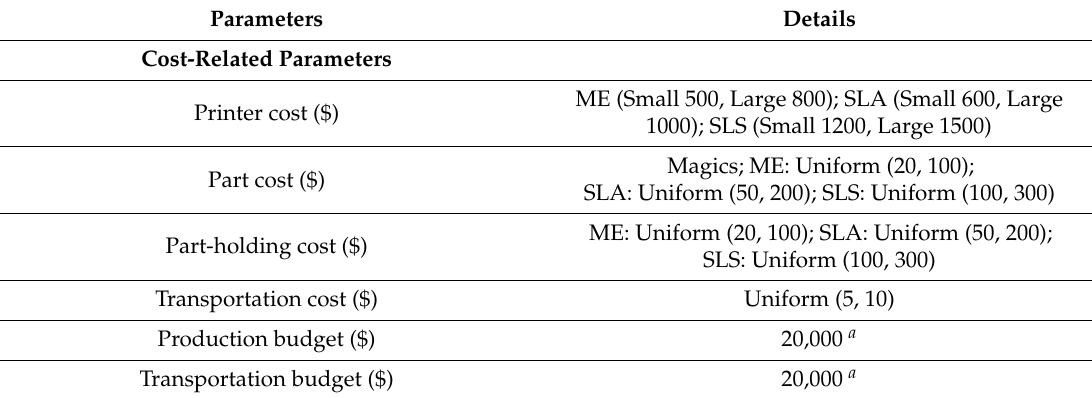
Table 4. Parameters for the case study and experimental